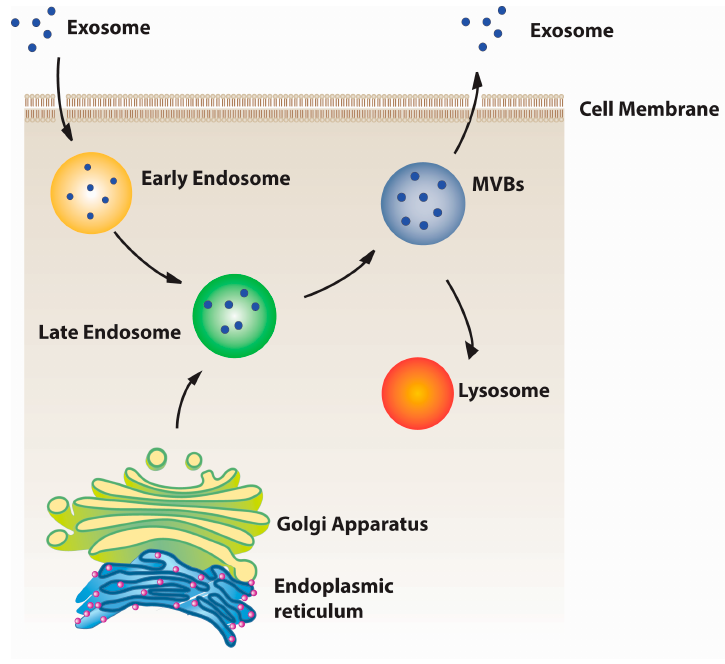
Figure 1. Exosome biogenesis: exosomes are generated in two distinct ways: the endocytic pathway and the biosynthetic pathway. The endocytic pathway begins by receiving extrinsic or intrinsic signals from the local milieu. Then, the plasma membrane begins to invaginate, and the early endosome subsequently forms. The early endosome becomes the late endosome under the regulation of multiple cell signaling pathways. The Golgi Apparatus and the endoplasmic reticulum also participate in exosome secretion. The multivesicle body resulting from the late endosome fuses with the plasma membrane and releases the exosome, or undergoes degradation. Table 1. Exosome, microvesicle, apoptotic body: major similarities and differences.